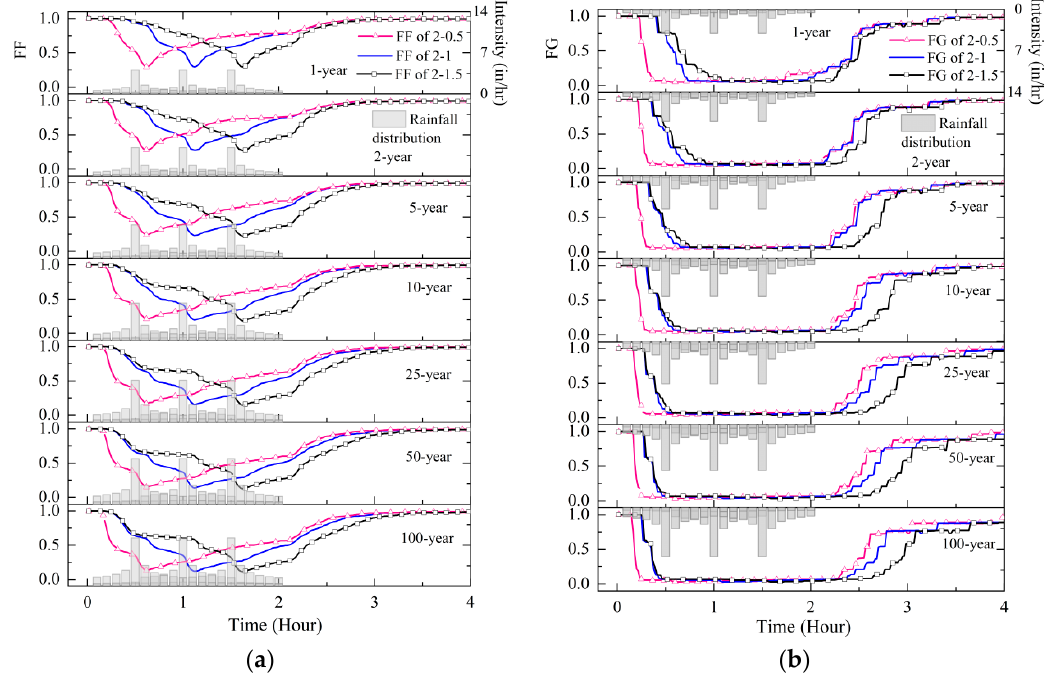
Figure 3. The variations in the values of the fractions of FF and FG in different rainfall patterns. ( a ) FF, ( b ) FG. The grey histogram is the rainfall distribution, the pink curve with triangles is the 2-0.5 event, the blue line is the 2-1 event, and the black line with squares displays the 2-1.5 event.